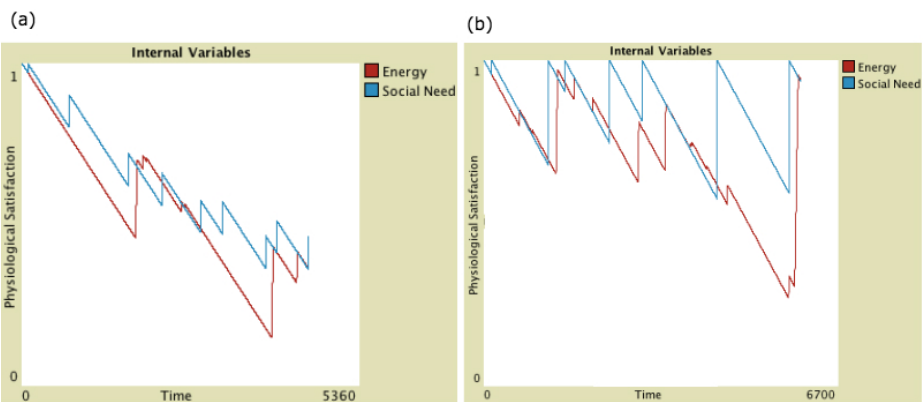
Figure 6. Comparison of the physiological satisfaction of the Energy (red) and SocialNeed (blue) within an agent. ( a ) A simulation run when touchingIntensity = 10%. ( b ) A simulation run when touchingIntensity = 60%. Please note that the higher the rate of physiological satisfaction for Social Need , the more an agent can satisfy its Energy value through the Eat